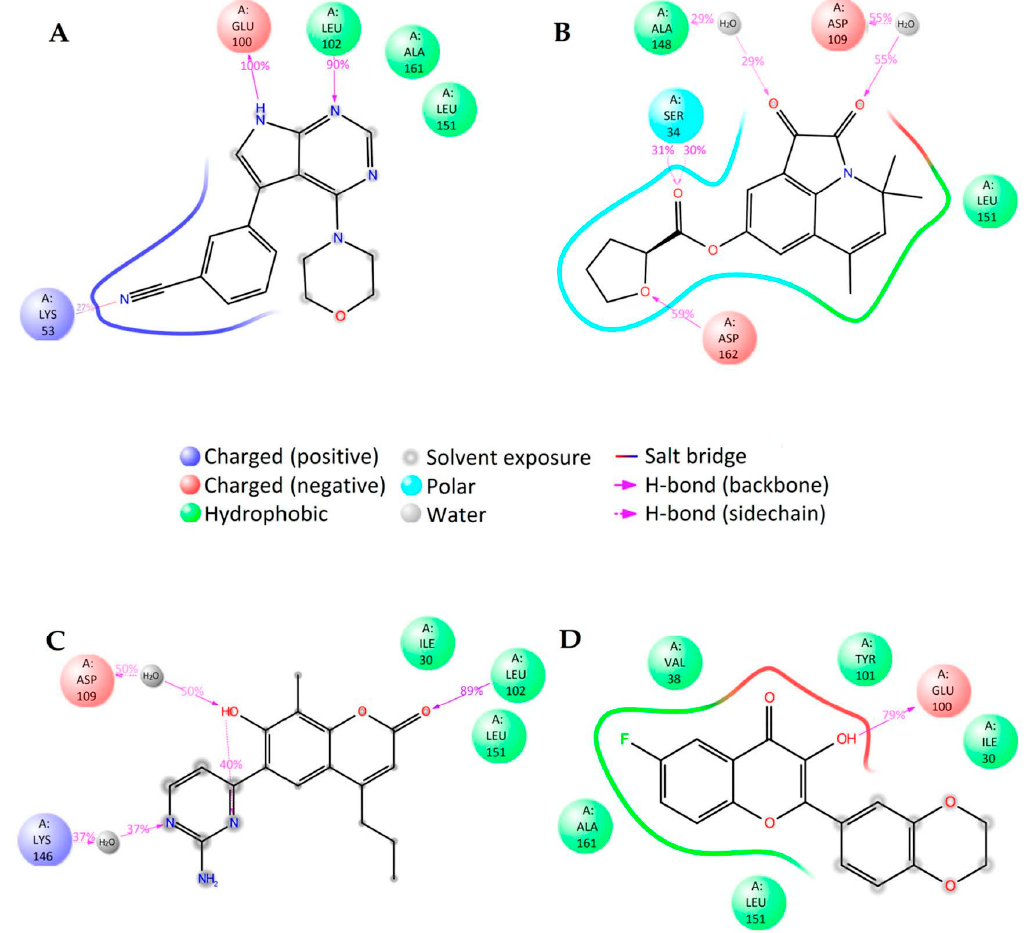
Figure 6. 2D summary of the molecular dynamics calculated contacts between compounds ( A ) ( A ) PF-06447475, ( B ) 1L , ( C ) 2L , ( D ) 3L and PF-06447475 , ( B ) 1L , ( C ) 2L , ( D ) 3L and LRRK2.